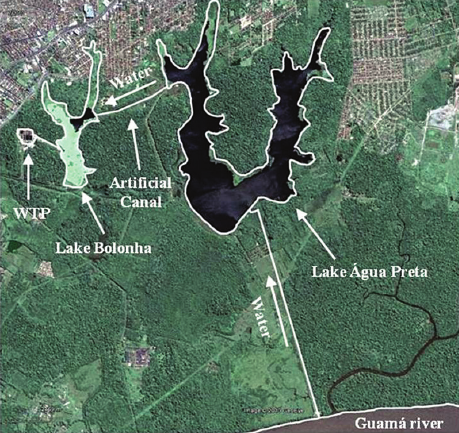
Figure 2 - Water supply complex of the metropolitan region of